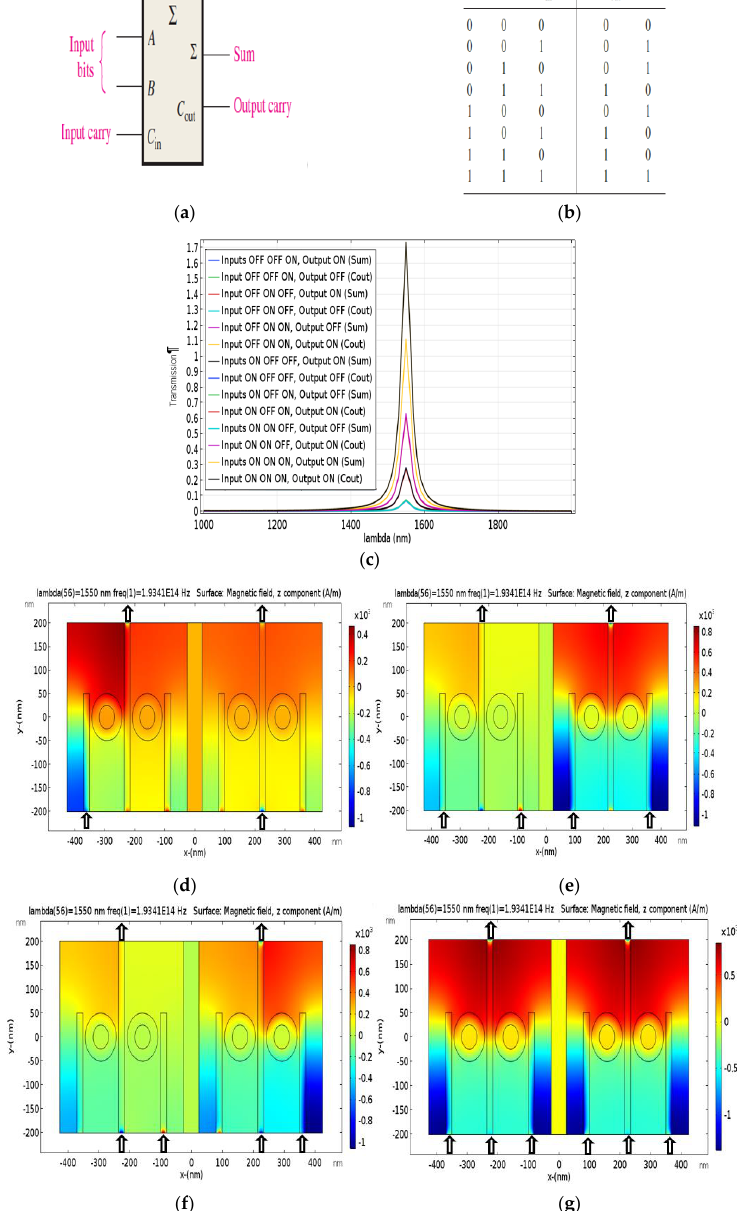
Figure 5. ( a ) and ( b ) the conventional full-adder logic symbol and its truth table, respectively. ( c ) The transmission spectrum of the proposed plasmonic full-adder for different states, according to its truth table. ( d ), ( e ), ( f ) and ( g ) the magnetic field distribution of Logic 001, 011, 110, and 111 inputs,